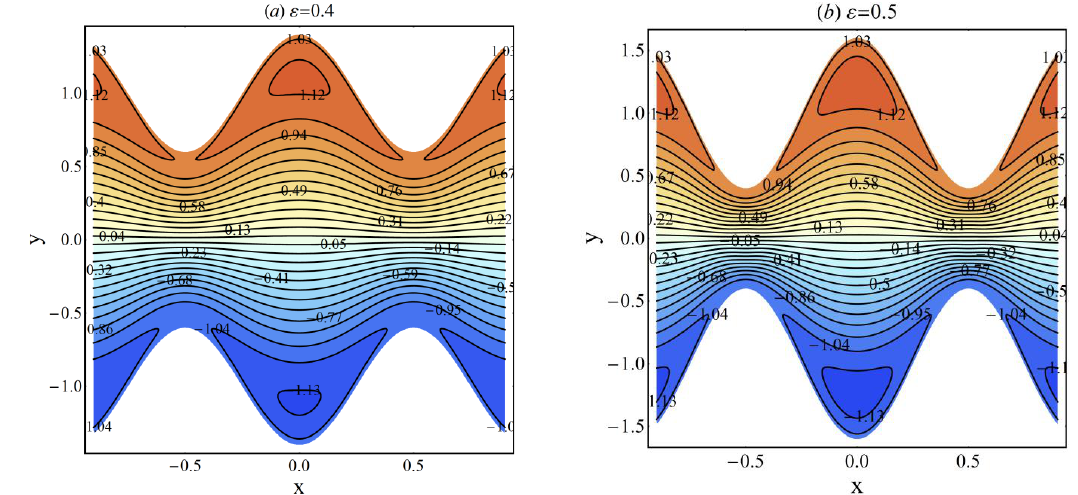
Figure 20. Streamlines at different ε when Fr = 1, n = 0.2, α = 0.1, We 2 = 0.01, β = 0.5, ξ = π/3, Fr = M = 0.5: (a) ε = 0.4 and (b) ε = 0.5.